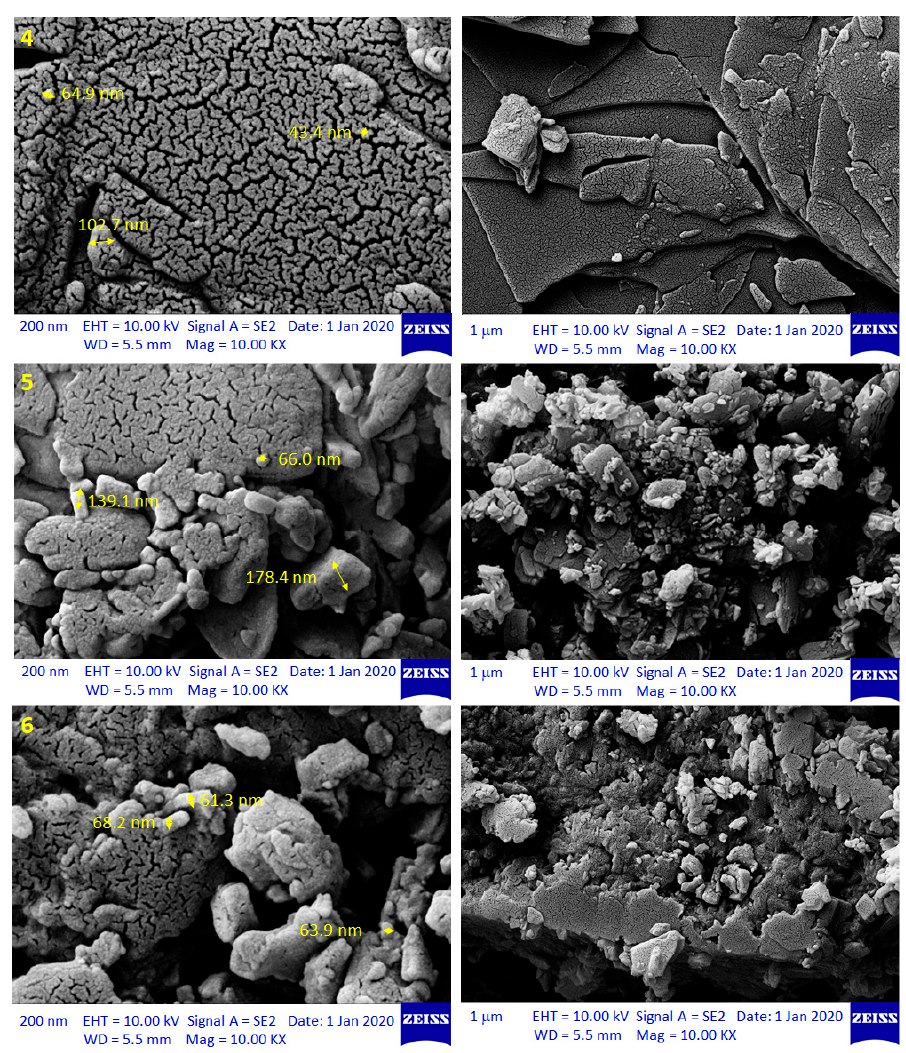
Figure 1. Field emission scanning electron microscopy (FESEM) images of polymers 4–6 .